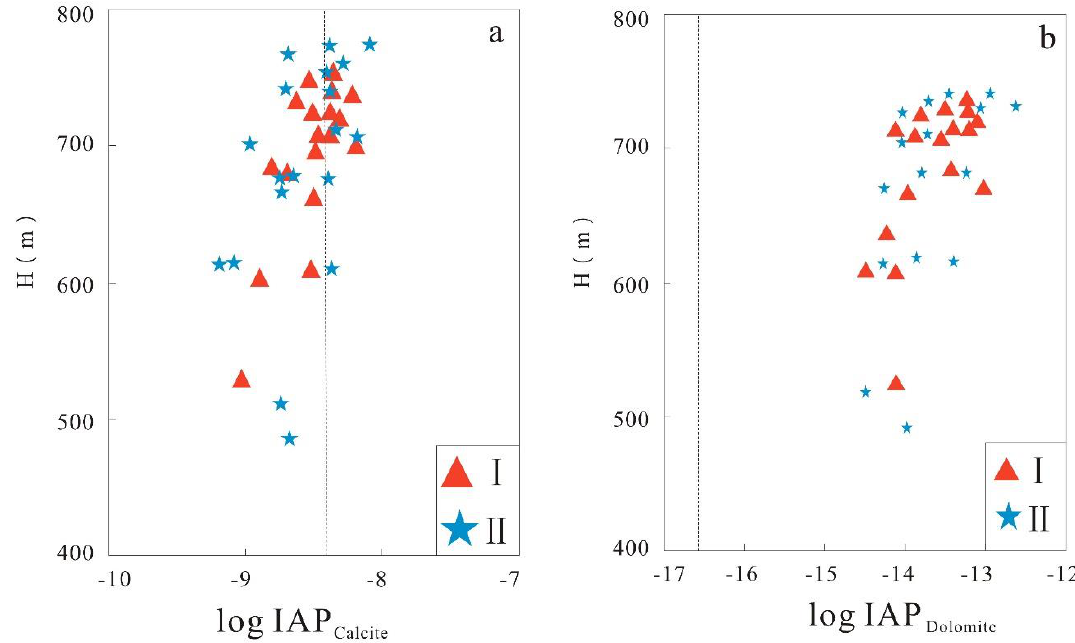
Figure 10. Depth profiles of log IAP for ( a ) calcite and ( b ) dolomite calculated using the Ca 2+ , Mg 2+ , and CO 32 − concentrations in water samples with hydraulic head (H). Dashed lines represent log K sp-Calcite and log K sp-Dolomite .